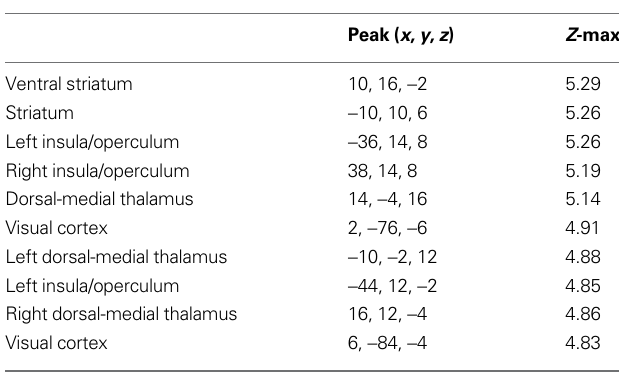
Table 2 | Self, Lose $4 > Lose $0.